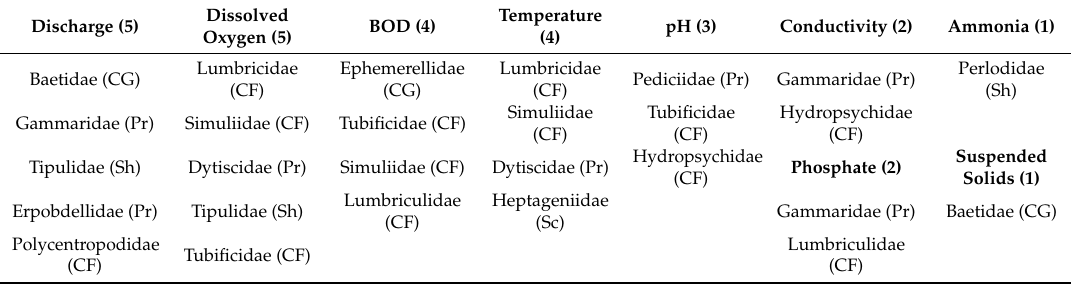
Table 4. Nodes (benthic macroinvertebrates) and the correlated edges (physicochemical variables) for the studied river. The numbers in brackets signify the connections between the nodes and the individual edges. The families were also classified based on their functional feeding groups